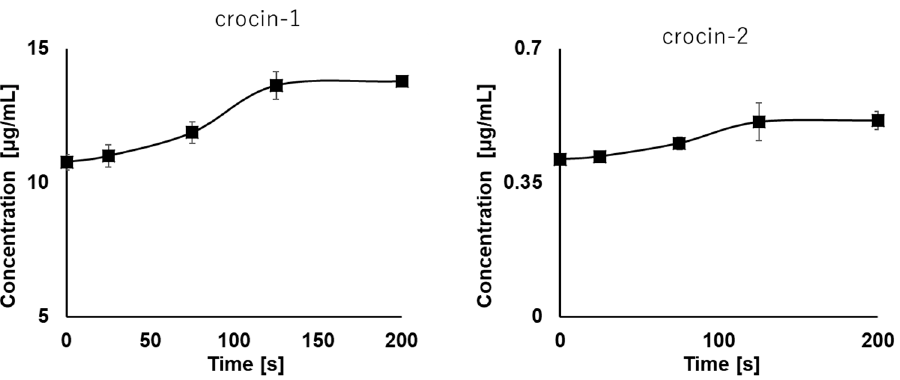
Figure 6. Effect of sonication time on extraction concentration of crocin-1 and crocin-2 in CXE80% extraction system with direct sonication (125 s, 20% amplitude) at 25 °C and 10 MPa. Error bars represent means ± SE (n = 3).